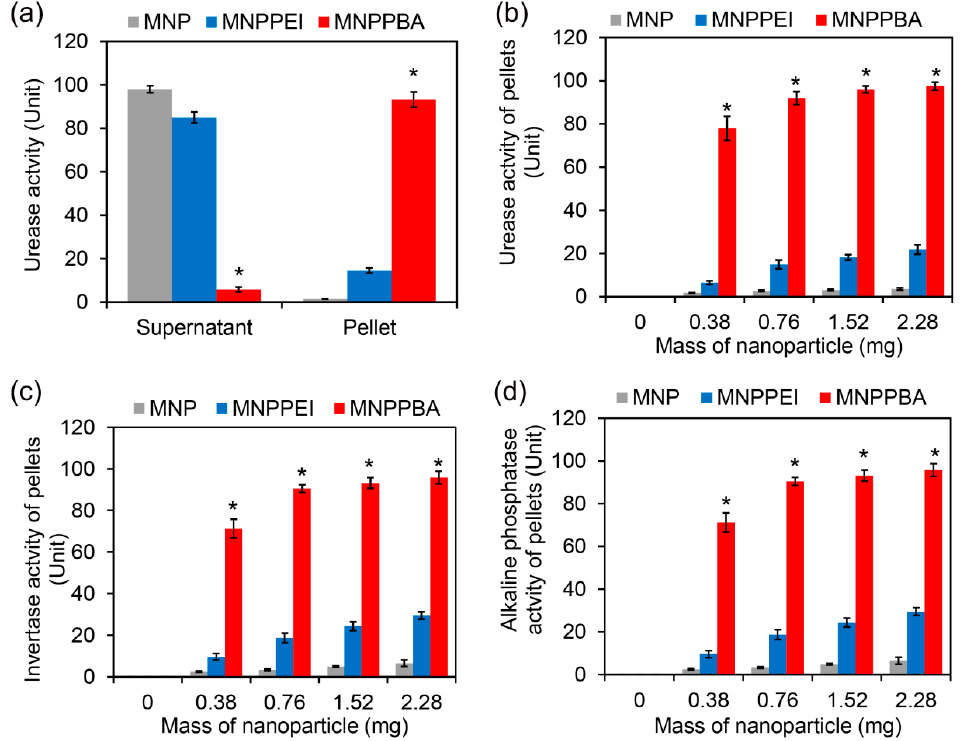
Figure 4. Enzyme capture and magnetic enrichment by the synthesized nanoparticles. ( a ) Urease activity of the supernatant and the nanoparticle pellets. 2.28 mg of the nanoparticles were added into 1 mL of the urease solution (100 U). After 5 min of co-incubation, the nanoparticles were sepa- rated by an NdFeB magnet. The nanoparticle pellets and the supernatants were used for detection of urease activity by a urease assay kit. ( b ) Urease activity of the nanoparticle pellets at different nanoparticle doses. ( c ) Invertase activity of the nanoparticle pellets at different nanoparticle doses. ( d ) Alkaline phosphatase activity of nanoparticle pellets at different nanoparticle doses. The aster- isks (*) indicate a significant difference between MNPPBA and the other two groups ( p < 0.05). 2.4. Sensitive Rhizosphere Enzyme Assay Based on the Synthesized Magnetic Nanoparticles The actual soil situation is complex, meaning that the capture process of enzymes by magnetic nanoparticles may be affected [33,34]. When using Amaranthus hypochondriacus rhizosphere soil as the detection object, MNPPBA still showed the highest enzyme capture efficiency. Soil particles and other compositions did not inhibit the combination between nanoparticles and enzymes [35]. As shown in Figure 5, the great differences of the detec- tion results between traditional and nanoparticle-based assay indicate that traditional as- say could not reflect the soil enzymes activities accurately, especially when detecting the small amount of sample containing trace enzymes, such as plant root tissue. The results in Figure 5 also show that nanoparticle-based assay was more sensitive and more accurate and could accurately reflect the slight changes in enzyme activities in a tiny area of the soil. It is helpful to research the response mechanism of plants and mi- croorganisms to the changes in the soil ecological environment, as well as the role of the rhizosphere microbial system in different growth stages of plants [36].